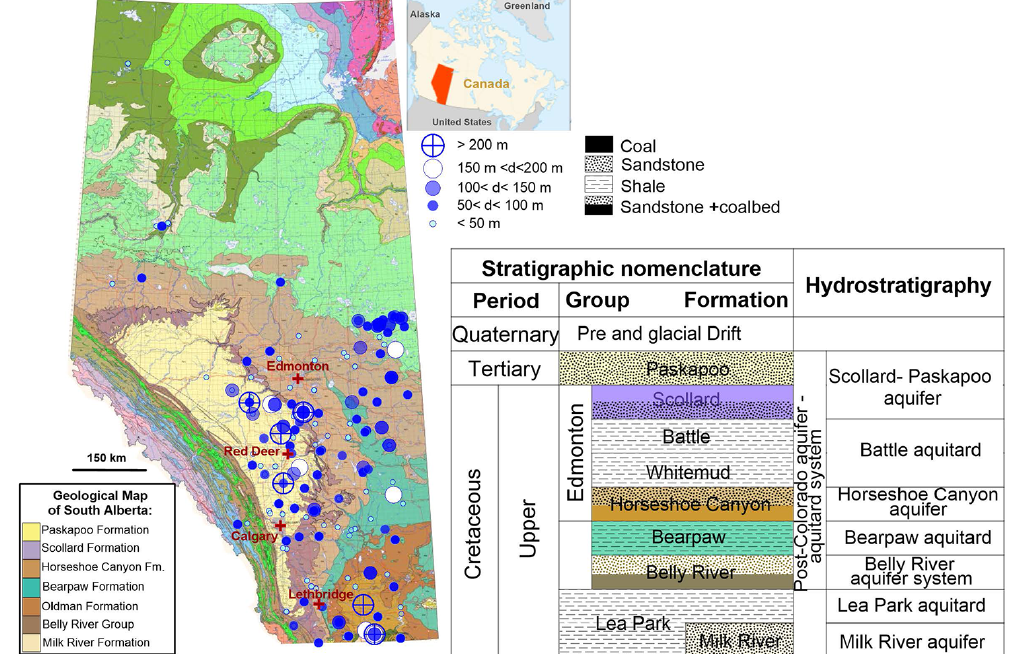
Figure 1. Location and depths of 186 water wells from the GOWN monitoring program used in this study shown on a geological bedrock map of Alberta (Alberta Geological Survey). Also shown is a stratigraphic column for southern Alberta (modified from Bachu, 1999).